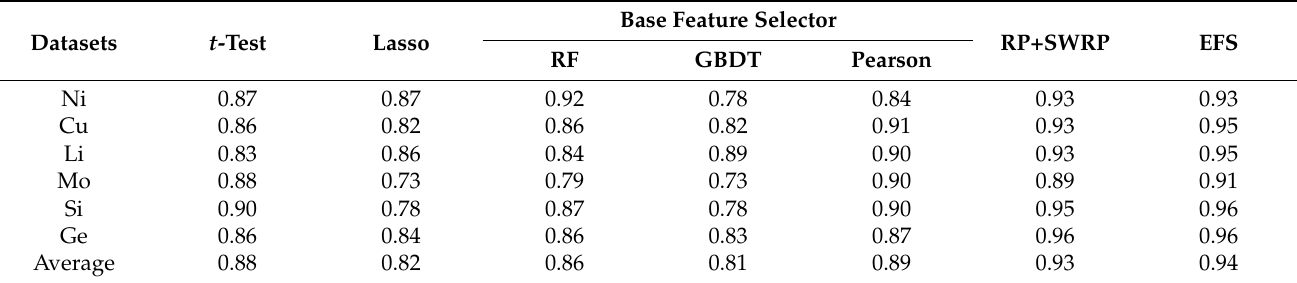
Table 8. Stability comparison between EFS and